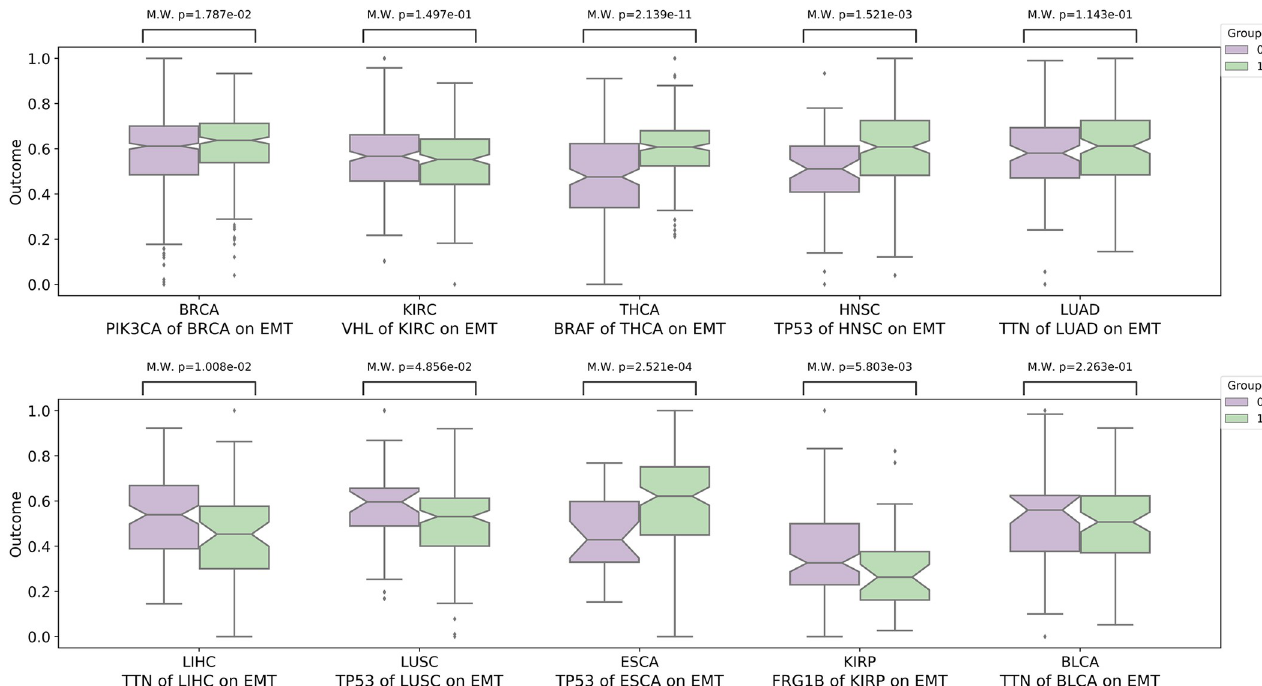
Fig 8. The Mann-Whitney U test (M.W.) analysis shows there is no significant differences between mutated groups and non-mutated groups of mutated genes with high mutation rates in the activity of EMT process for 10 cancers.